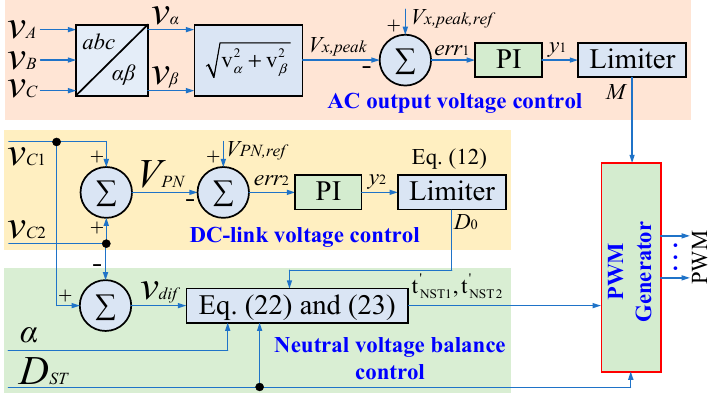
Figure 6. Coordinate control between capacitor voltage balance and DC-link voltage regulation. For the DC-link voltage regulation, the actual value of V PN is obtained by totaling V C 1 and V C 2 . The difference between V PN and the desired DC-link voltage, V PN,ref , is minimized by applying the PI controller. The coefficient D 0 is reached by limiting the output of the PI controller by (12).